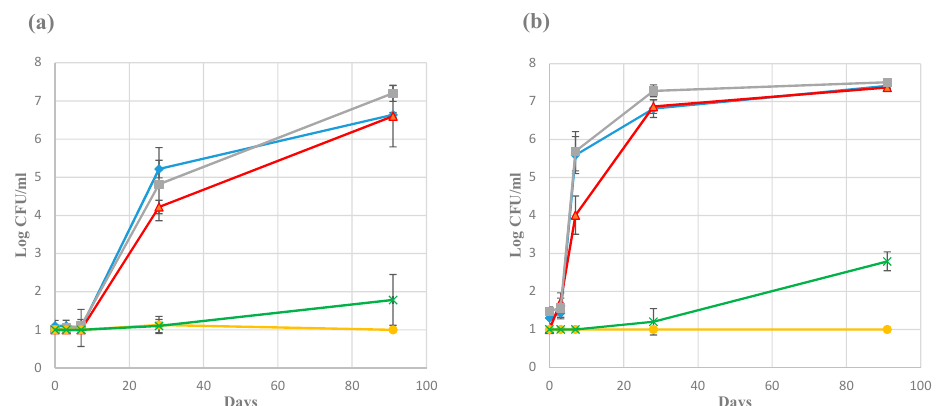
Figure 2. Microbial growth in brine during rakfisk ripening from the first year from Producer 1 ( a ) and Producer 3 ( b ). Error bars represents the standard deviation of the triplicate biological replicates. The detection limit was 20 CFU/mL. 10 CFU/mL were used as default number from the plates where no growth could be detected. ■ (grey), BA; ♦ (blue), PCA; ▲ (red), MRS; x (green), VRBG; ● (yellow), DRBC (Dichloran Rose Bengal Chloramphenicol).